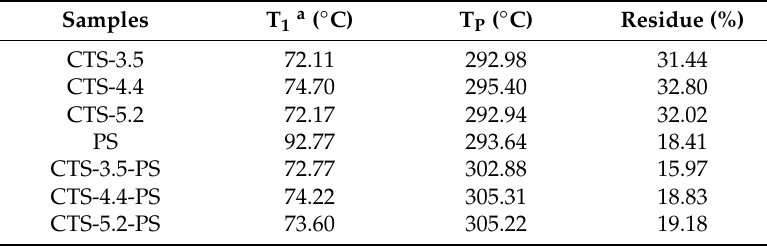
Figure 7. Thermal decomposition process of materials ( a ): raw materials, ( b ): CTS–PS foams. Table 8. Thermal decomposition parameters of